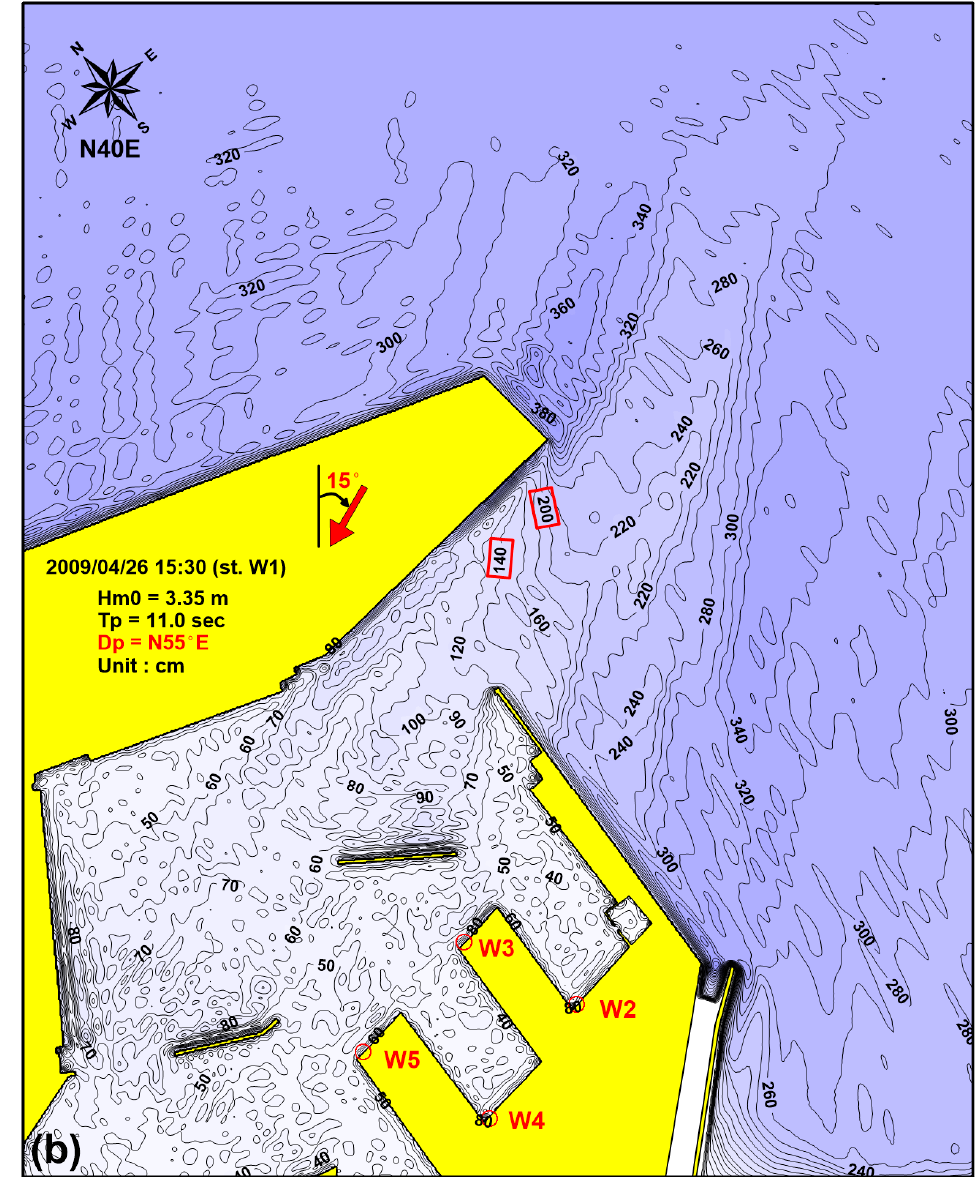
Figure 18. ( a ) Contours of wave height isolines in the case of BC. The model conditions were the same with those in Figure 16, except that D p , the input wave direction along the outer open boundary, was set as N15.0 ◦ E as an example of extreme conditions that represented NNE waves; ( b ) the same as ( a ), except that D p was set as N55.0 ◦ E as for an example of extreme conditions that represented NE waves. In the case of the extreme NE waves (N55.0 ◦ E), the waves could enter into the port easily compared to the case of N15.0 ° E.